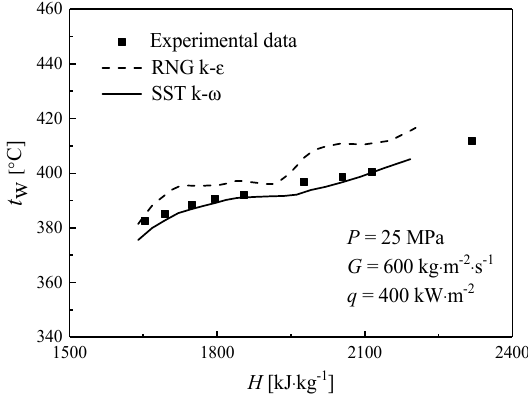
Figure 5. Turbulence model verification results (exp. Data from [33]).